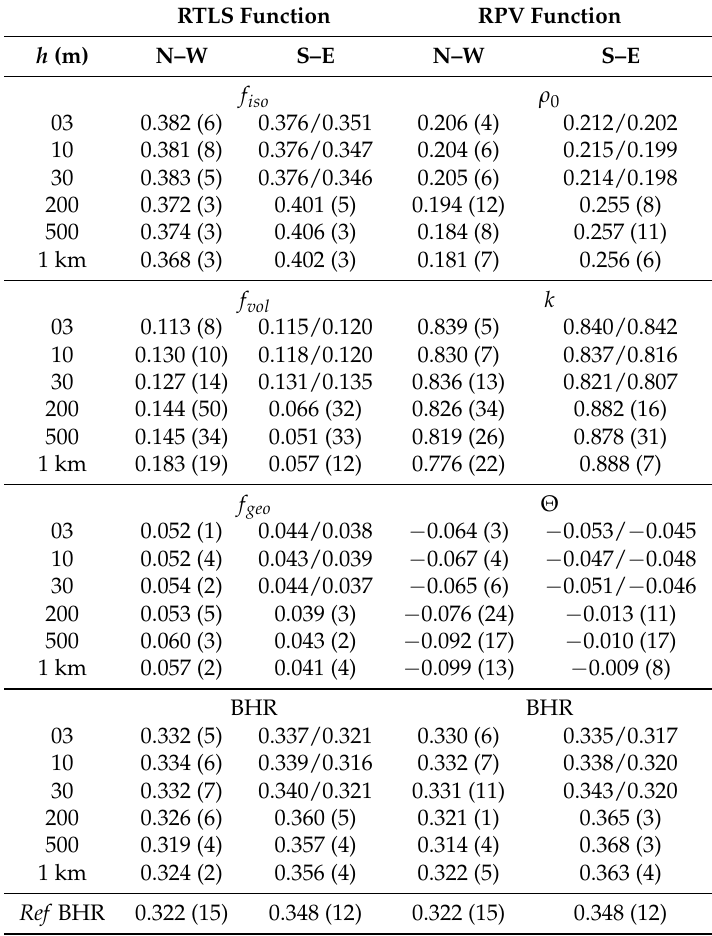
Table 6. Statistics of the RLTS and RPV parameters as obtained by optimization of the simulated PARABOLA ( h of 3, 10, 30 m) and CAR (200, 500, 1000 m) measurements. Values obtained for PARABOLA over P7 and P8 (S–E) were not averaged and are reported independently separated by the “/” symbol. Points P2–P6 were used to compute the statistics over the N–W area for PARABOLA. Loops L1–L6 and L8–L11 were used to compute the statistics for CAR over the N–W and S–E sectors, respectively. The numbers in parenthesis indicate the standard deviation and refer to the last digit of the average value. RTLS Function h (m)